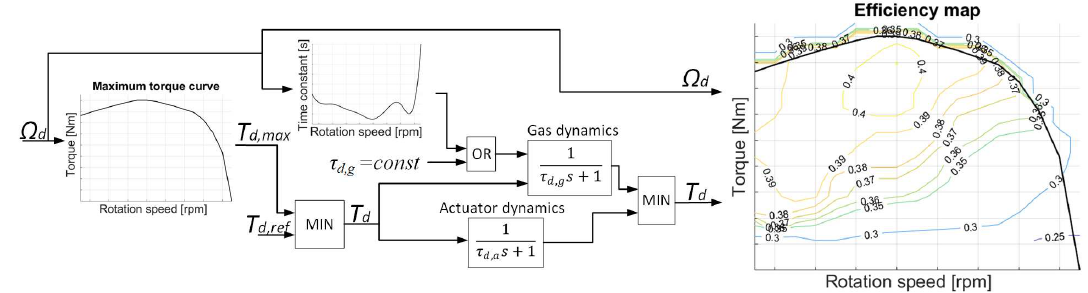
Figure 3: Block diagram of diesel engine model